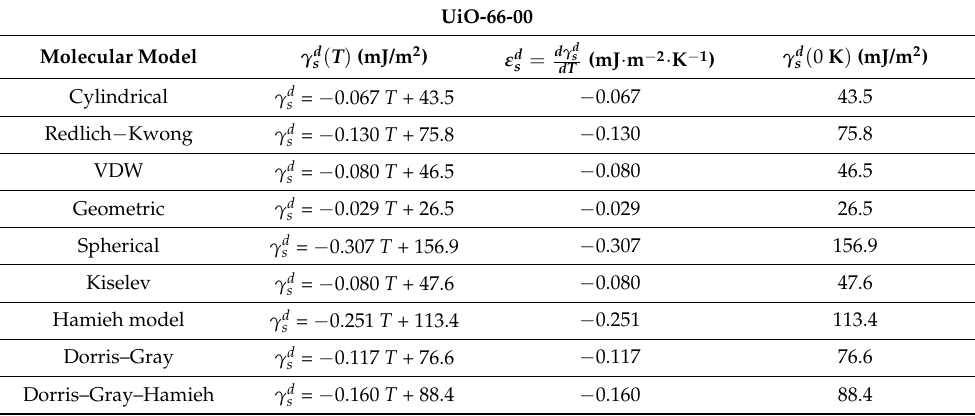
Table 2. Equations γ d s ( T ) of UiO-66-00 surface, the dispersive surface entropy ε d s , and the extrapolated values γ d s ( 0 K ) by using the different molecular and thermal Table 2. Equations 𝛾 𝑠𝑑 (𝑇) of UiO-66-00 surface, the dispersive surface entropy 𝜀 𝑠𝑑 , and the extrap- olated values 𝛾 𝑠𝑑 (0 K) by using the different molecular and thermal models.